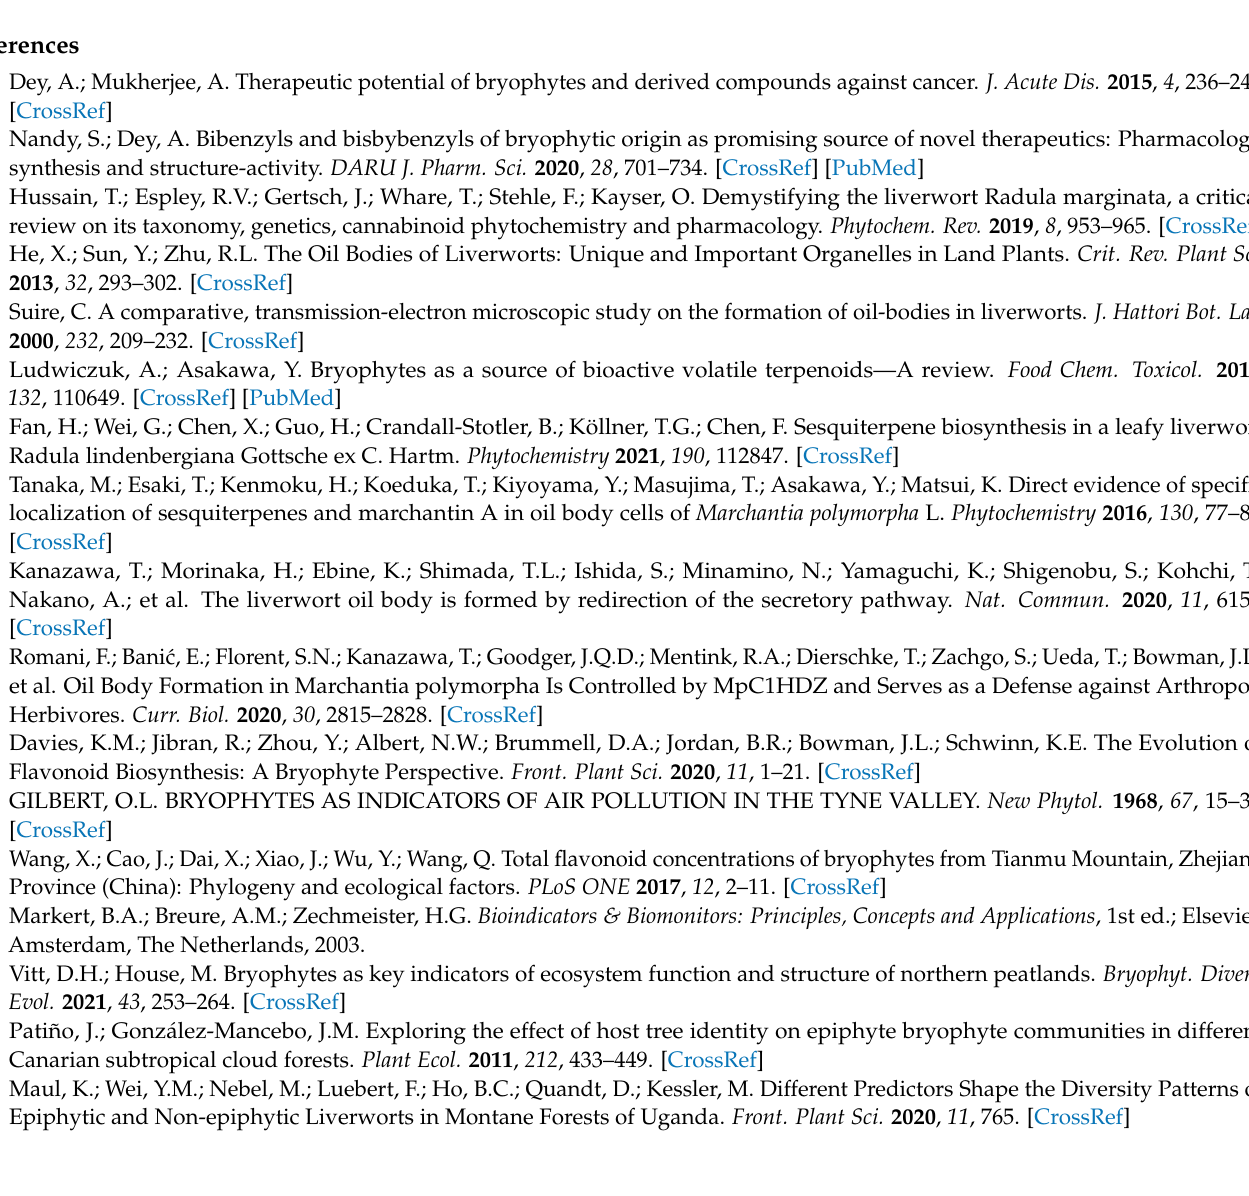
Table S5: Feature identification for Figure 5, Table S6: Feature identification for Figure